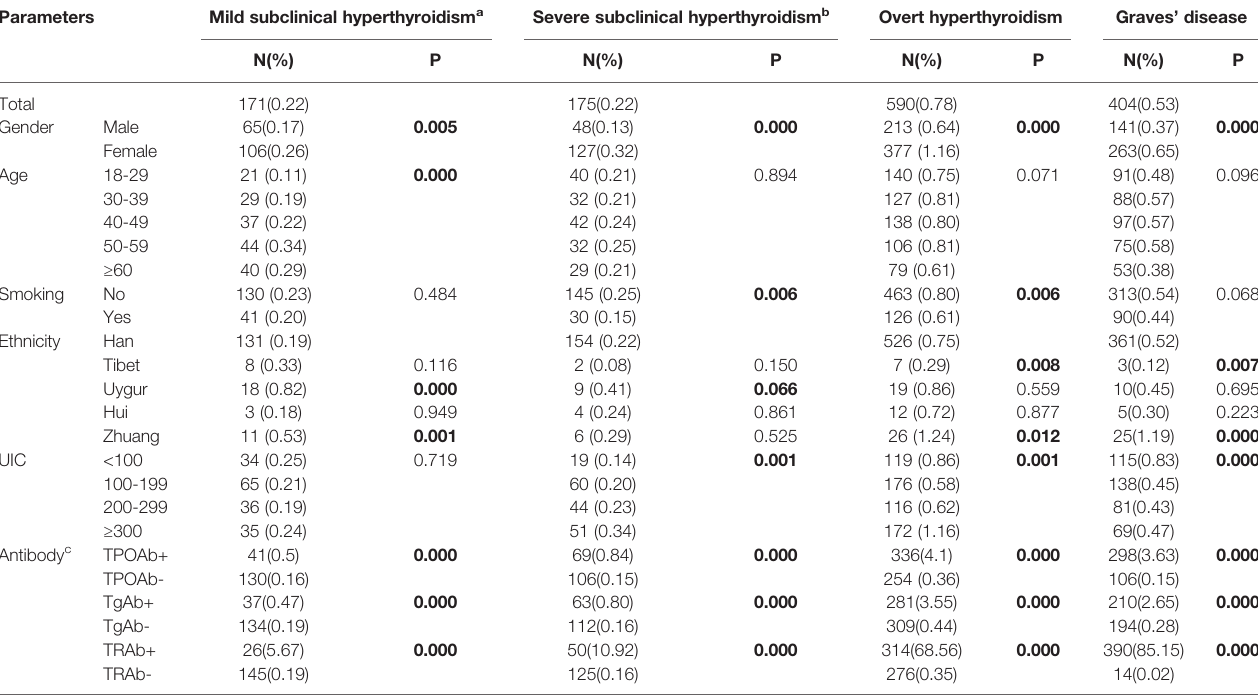
TABLE 2 | The prevalence of subclinical hyperthyroidism, overt hyperthyroidism and Graves ’ disease in different populations. Parameters